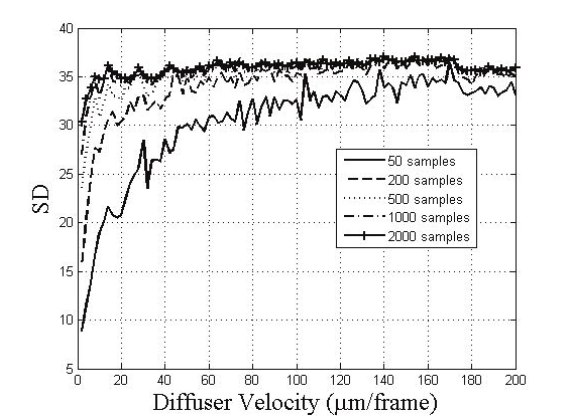
Fig. 2. Standard Deviation descriptor ( SD )